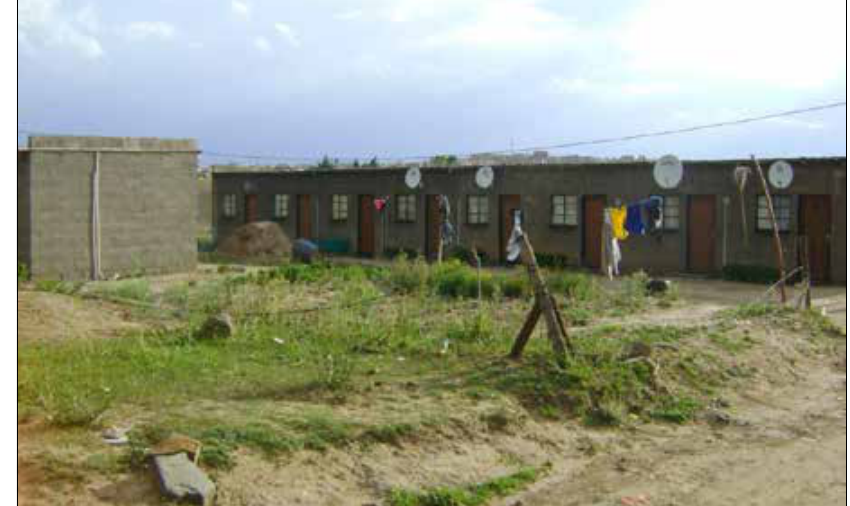
Figure 4: Housing units built for rent to workers in AGOA factories